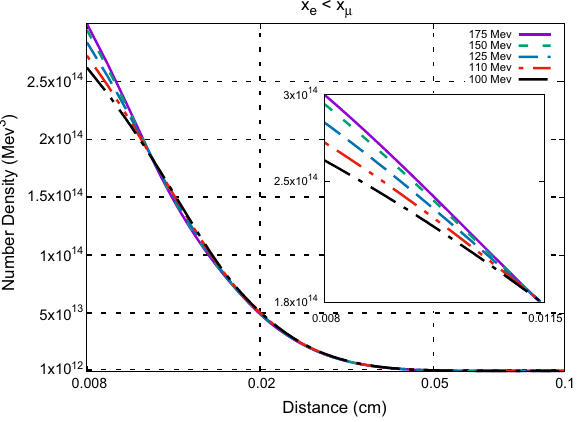
Fig. 4 The decay of the inhomogeneity in a plasma with equal number of electrons and muons